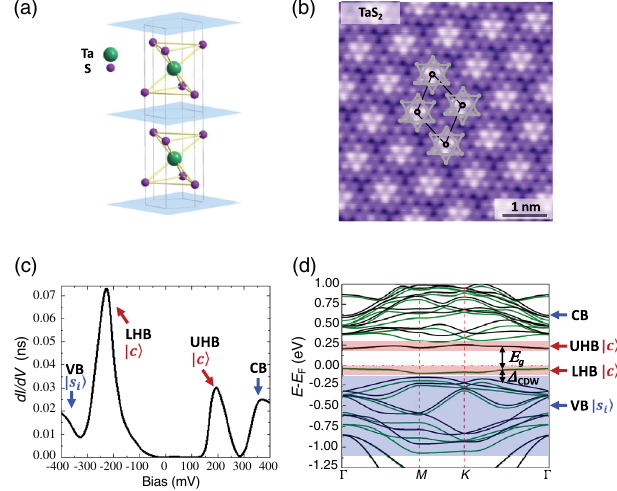
FIG. 1. Structural and electronic properties of 1 T-TaS 2 . (a) Crystal structure of 1 T-TaS 2 . (b) Atomic resolved topographic ¼ 1 V and tunneling image of 1 T-TaS 2 with bias voltage V b ¼ 20 pA. Each bright site on the surface corresponds to current I t a S atom in the topmost layer. The gray dots and the black lines mark the SD structure and the CCDW superlattice, respectively. The crystal cleaves easily between two adjacent S layers, as indicated by the blue planes in (a), exposing the triangular lattice of S atoms. (c) Spatial averaged STM dI=dV spectrum acquired at 5 K. (d) DFT þ U band structure of 1 T-TaS 2 . The black and green colored curves represent the two spin components. The shaded regions indicate the energy range belonging to the different